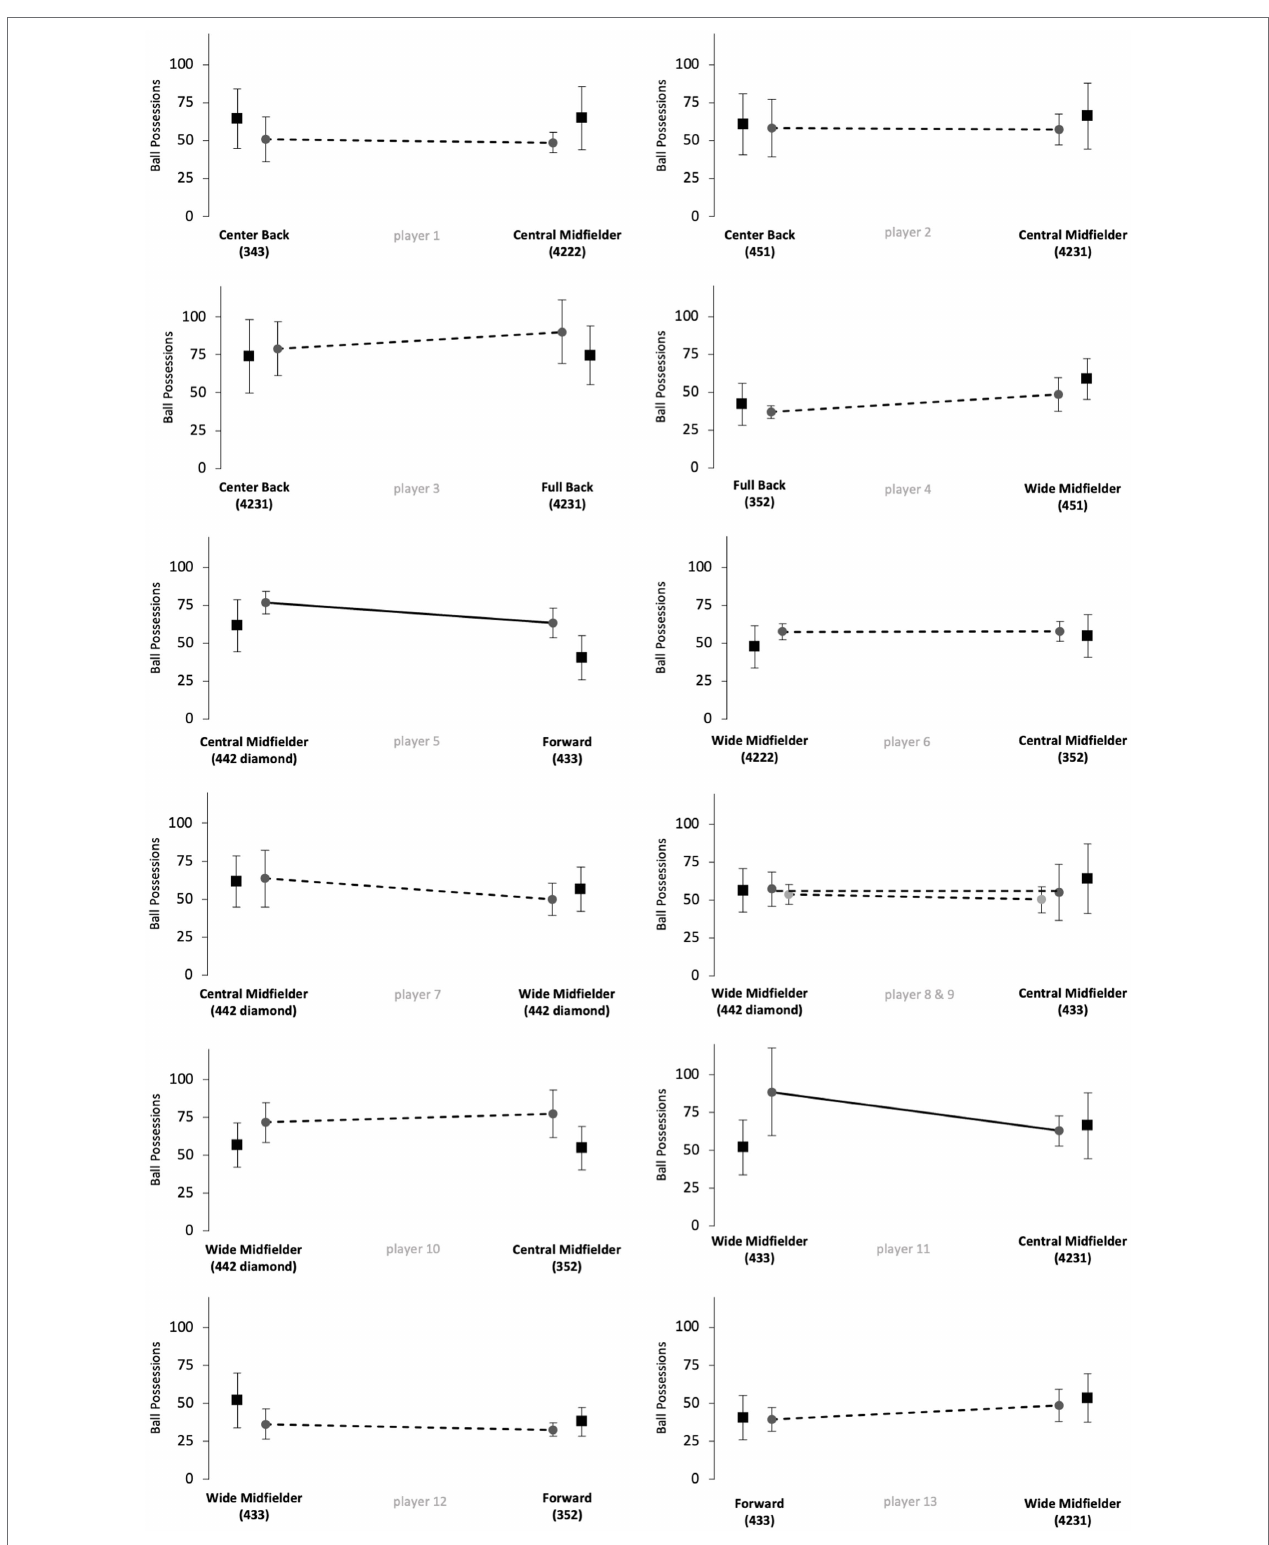
FIGURE 4 | Number of ball possessions of players from the study sample (grey circles) in relation to normative positional data (black squares). Data are presented as means ± SD for the respective games played on the respective positional role. Solid lines indicate significant differences in performance between the two positions for the respective